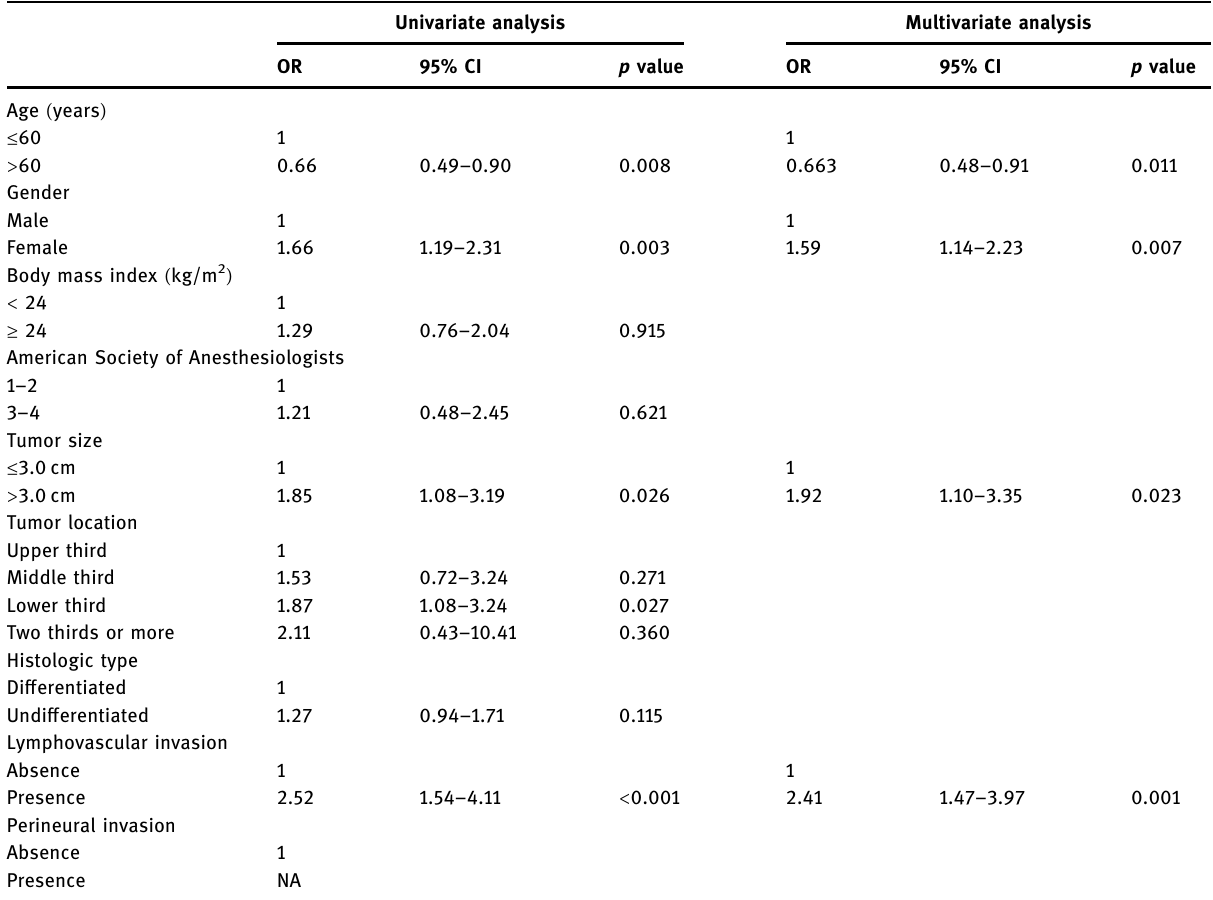
Table 3: Logistic analysis of clinicopathological features associated with lymph node metastasis ( pN1 )